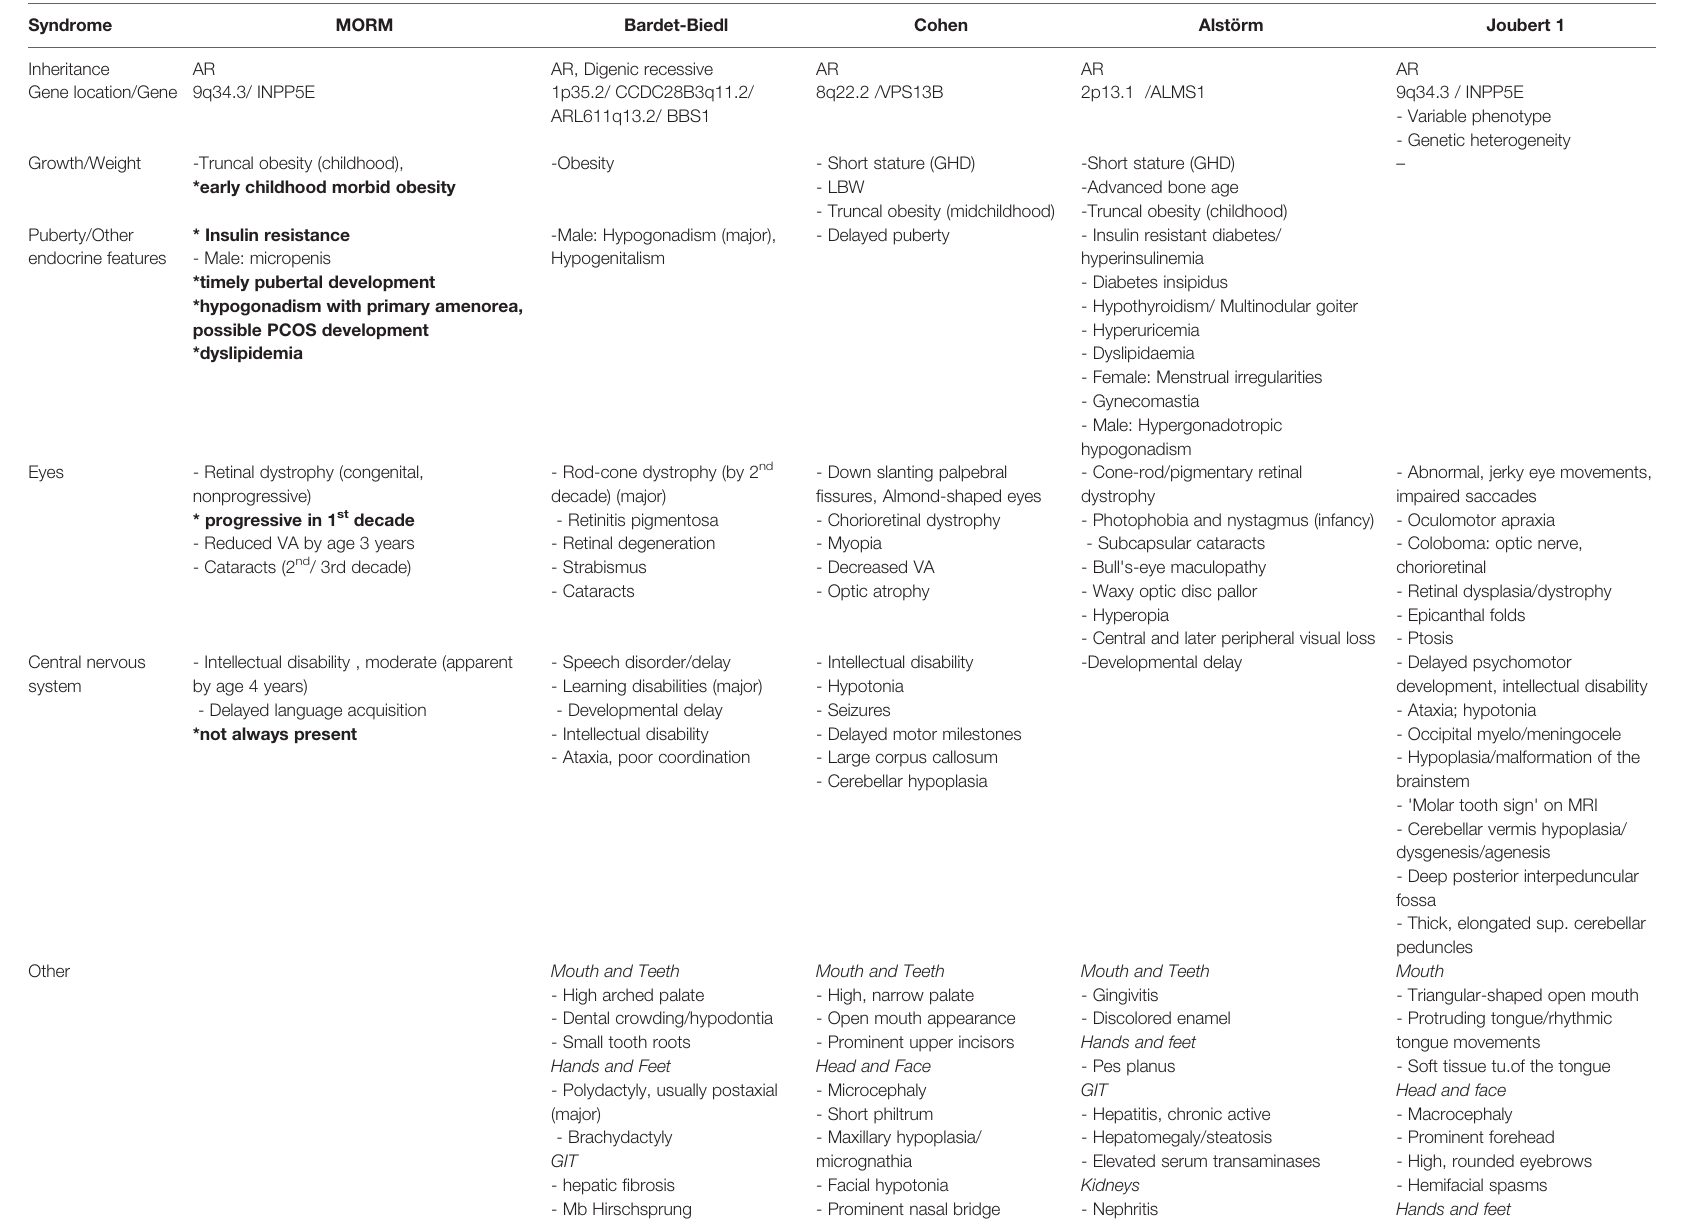
TABLE 2 | Phenotype comparison between MORM, Bardet-Biedl, Cohen, Alstörm, and Joubert 1 syndrome (OMIM